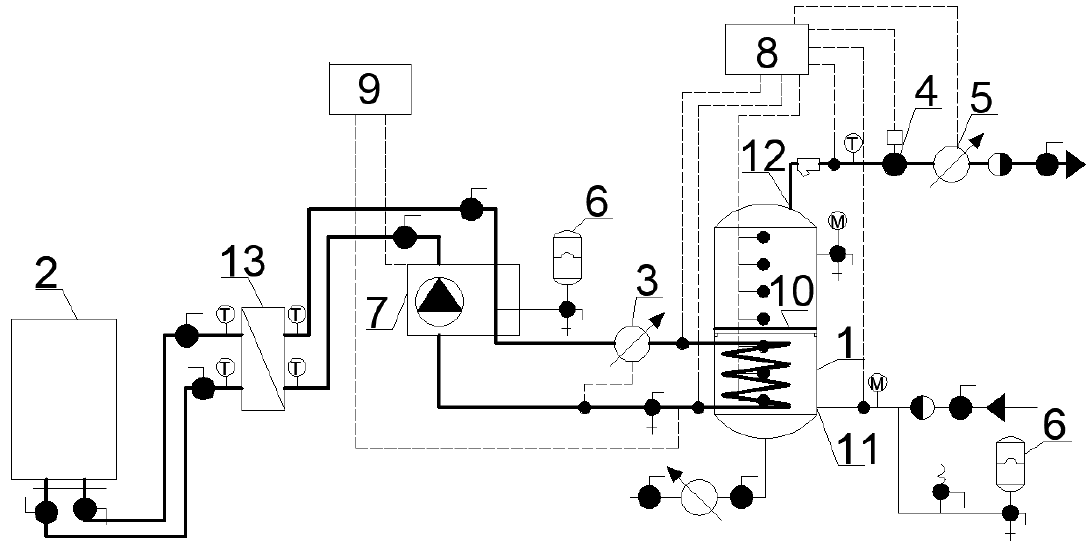
Figure 2. Diagram of the existing research installation for domestic hot water preparation: 1—hot water tank; 2—ultrathermostat; 3—heat meter; 4—drain solenoid valve; 5—flow meter; 6—diaphragm expansion vessel; 7—variable displacement pump; 8—regulation and measurement system; 9—regulator; 10—partition inside the tank; 11—cold water connection; 12—hot water connection; 13—counter-current heat exchanger.